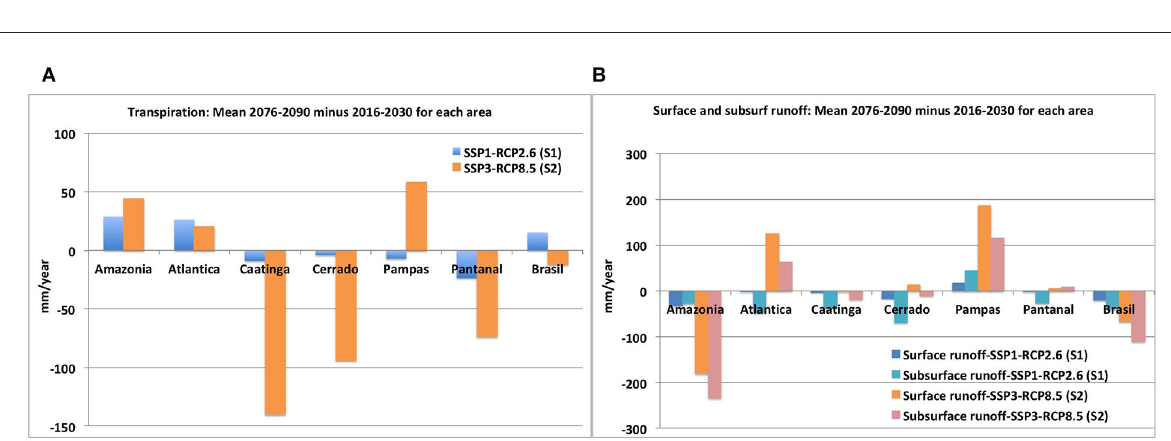
scenarios. Except for Caatinga (higher) and Cerrado (almost no change) in S1, NEP is decreasing for all biomes in the two